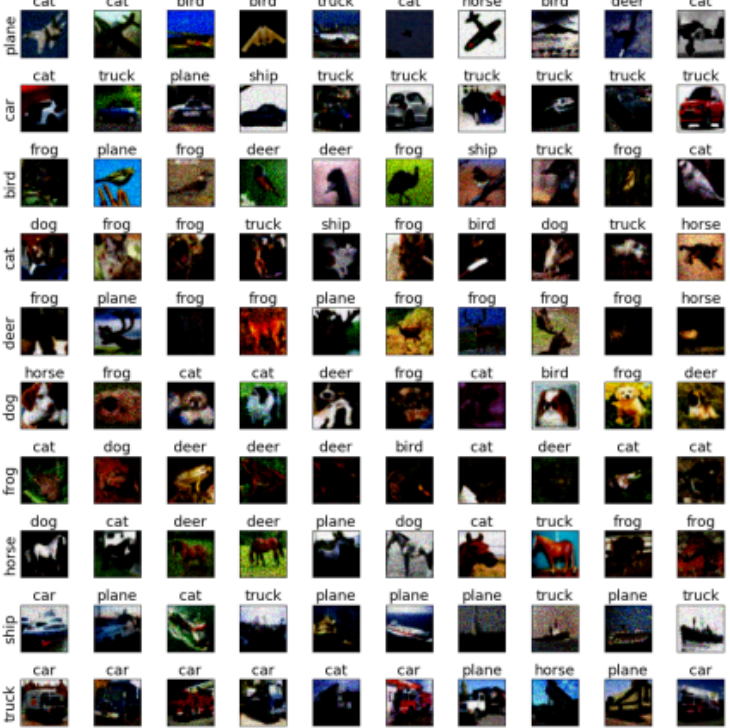
Figure 8. The adversarial examples of SAGM for Cifar10. Robustness is a metric used to evaluate the flexibility of DNNs to adversarial examples.